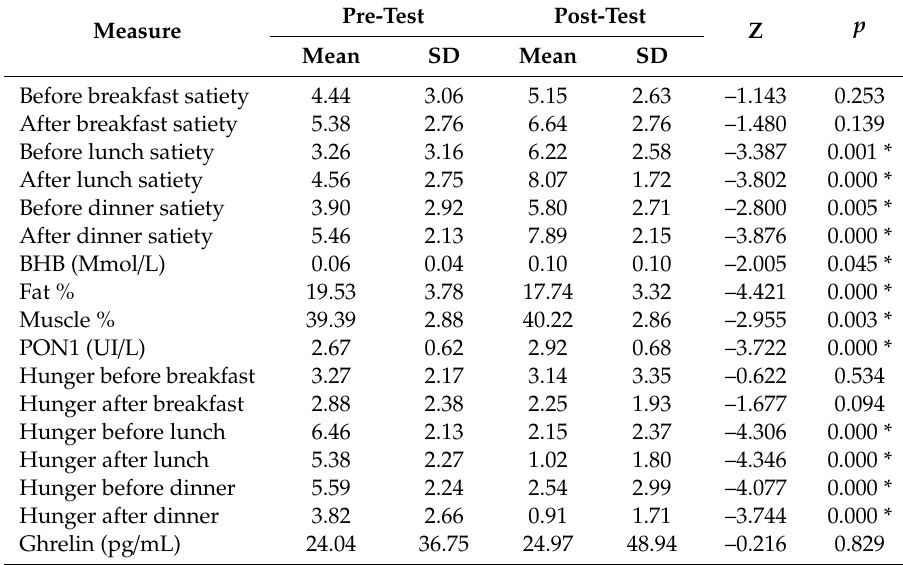
Table 3. Changes in satiety and hunger, muscle and fat, and BHB (beta-hydroxybutyrate), PON1 (paraoxonase 1) and ghrelin levels in